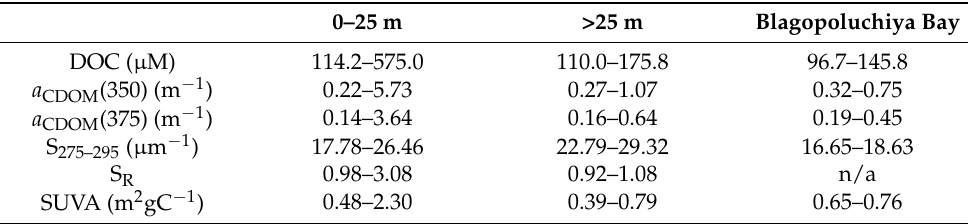
Table 1. Variation of DOC and optical characteristics of the Kara Sea waters.